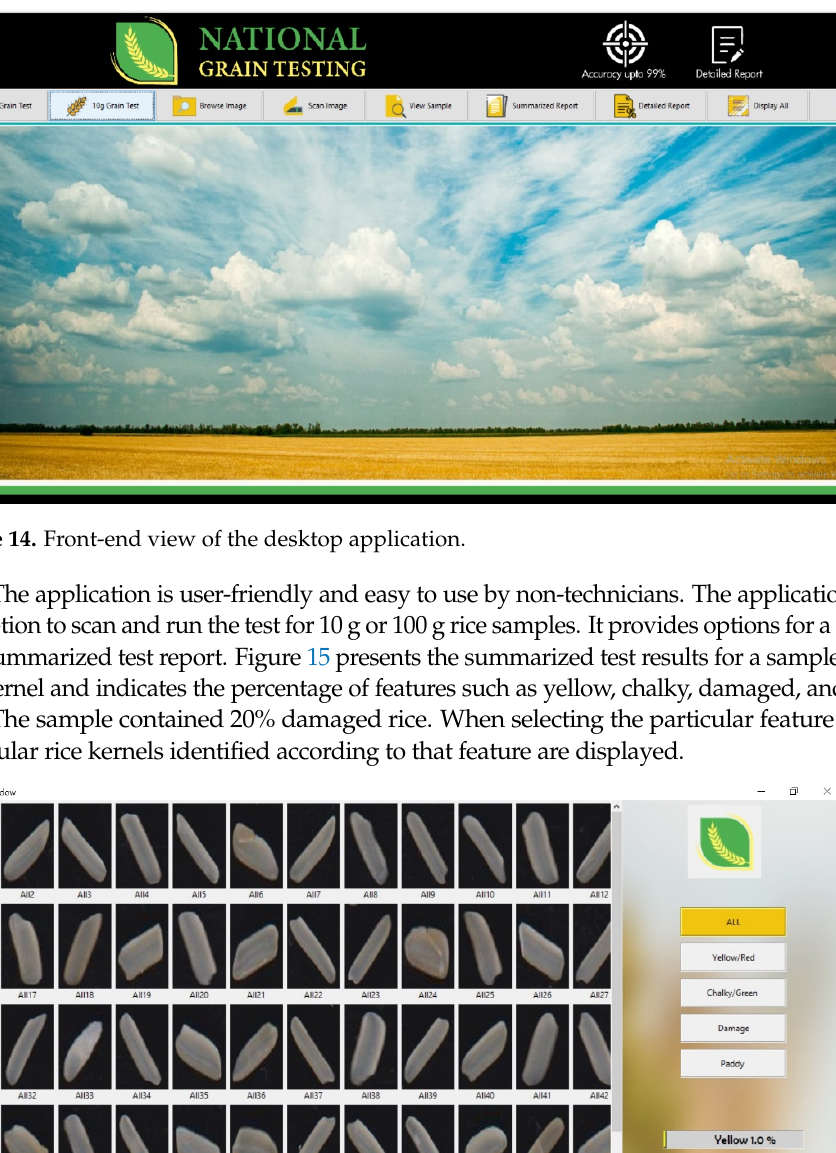
Figure 16 . National Grain Tech-generated report.